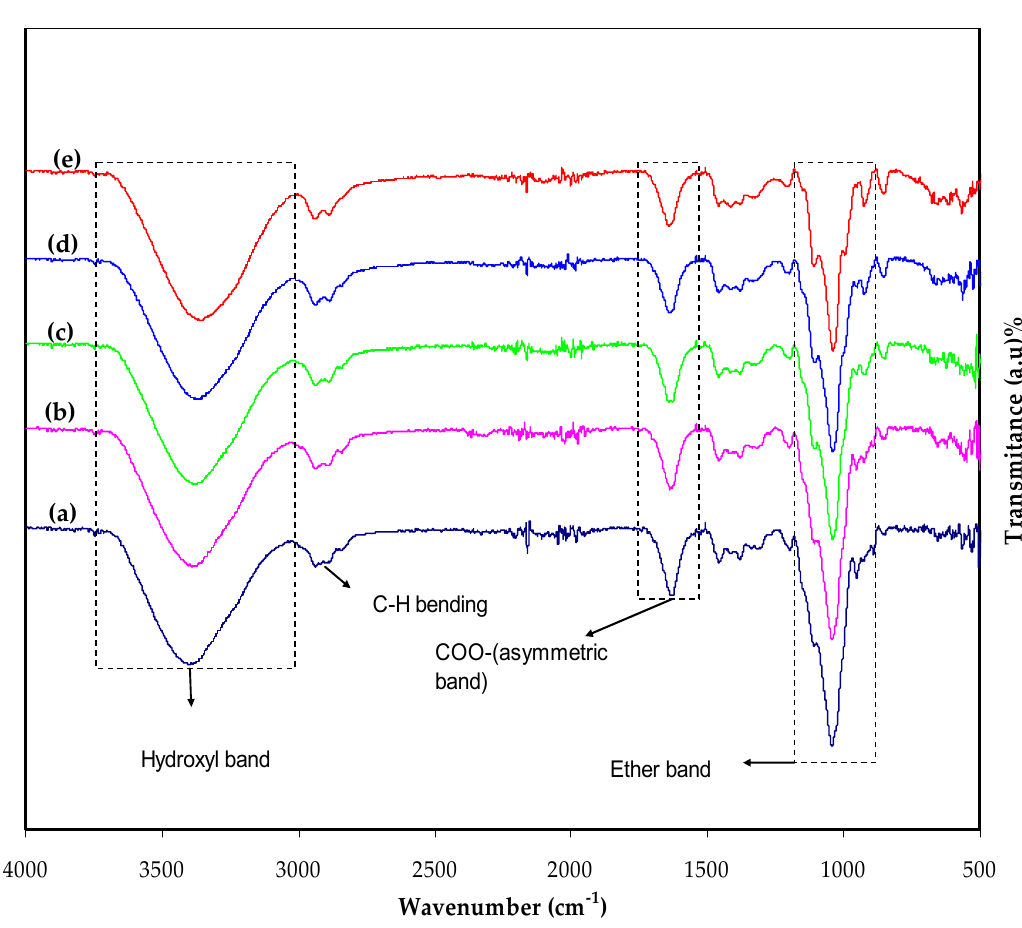
Figure 3. The Fourier transform infrared (FTIR) spectra of the prepared polymer electrolytes ( a ) MCPN1, ( b ) MCPN2, ( c ) MCPN3, ( d ) MCPN4, and ( e ) MCPN5.